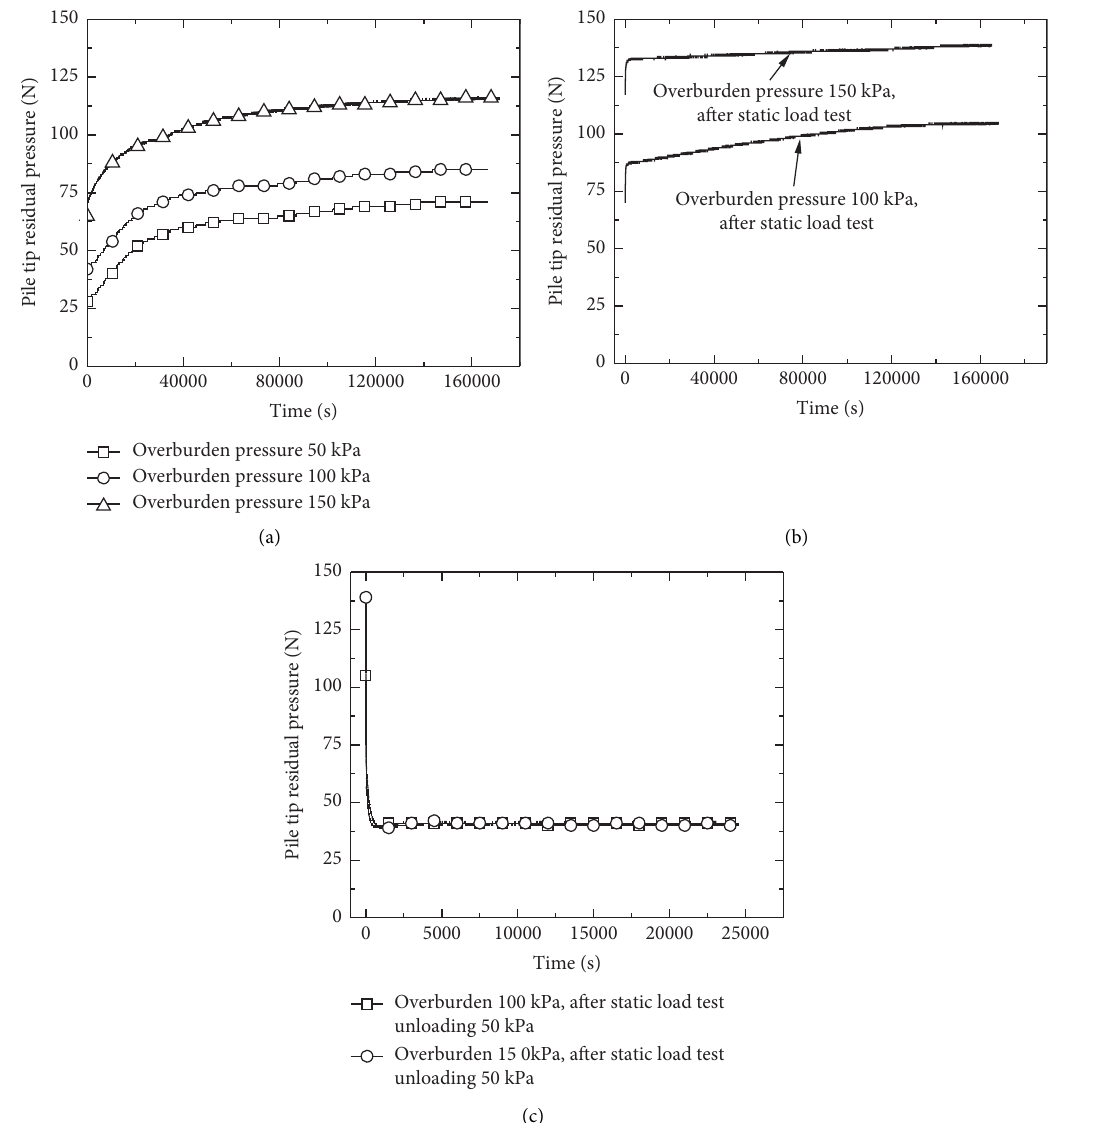
Figure 12: Variation of residual pressure at pile tip with time. (a) After completion of pile sinking. (b) After the static load test. (c) After